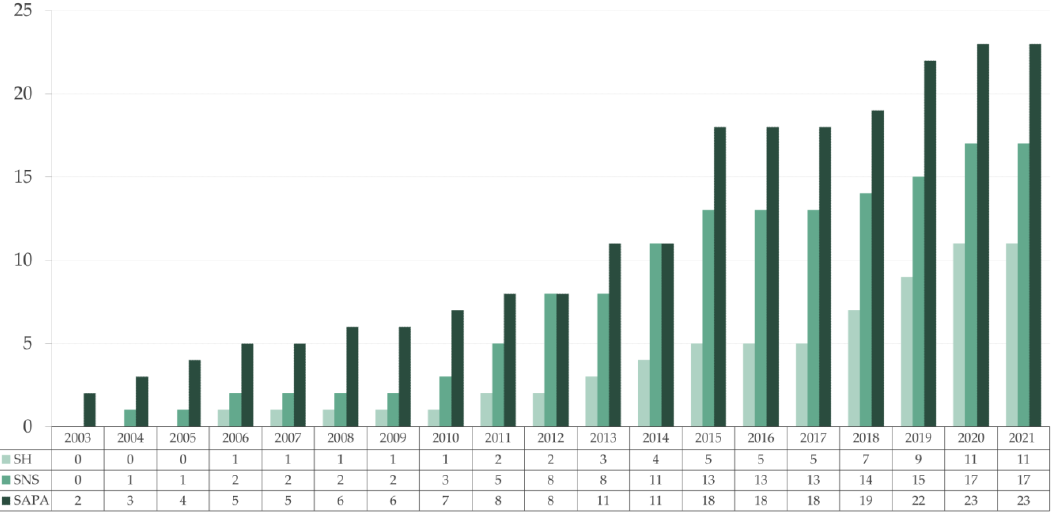
Figure 7. Evolution of receptive companies and activities. Source: [79]; authors ’ elaboration.